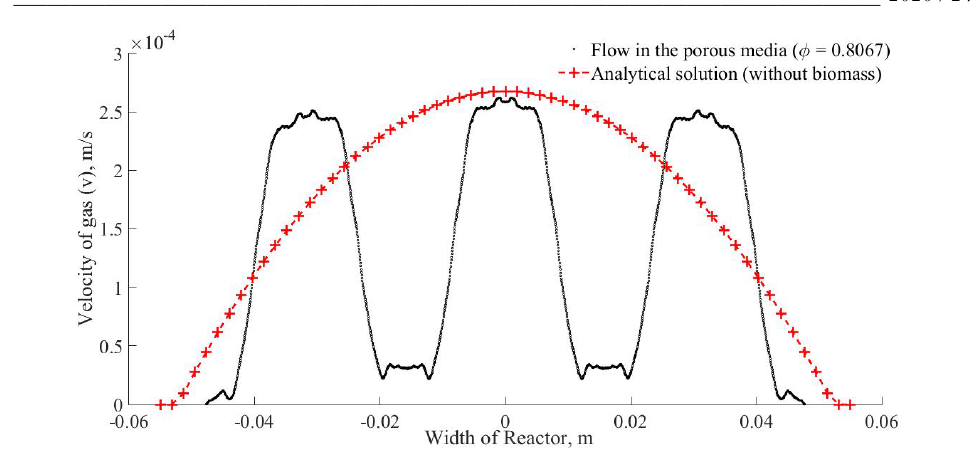
Fig. 13. Comparison of analytical solution with the LBM